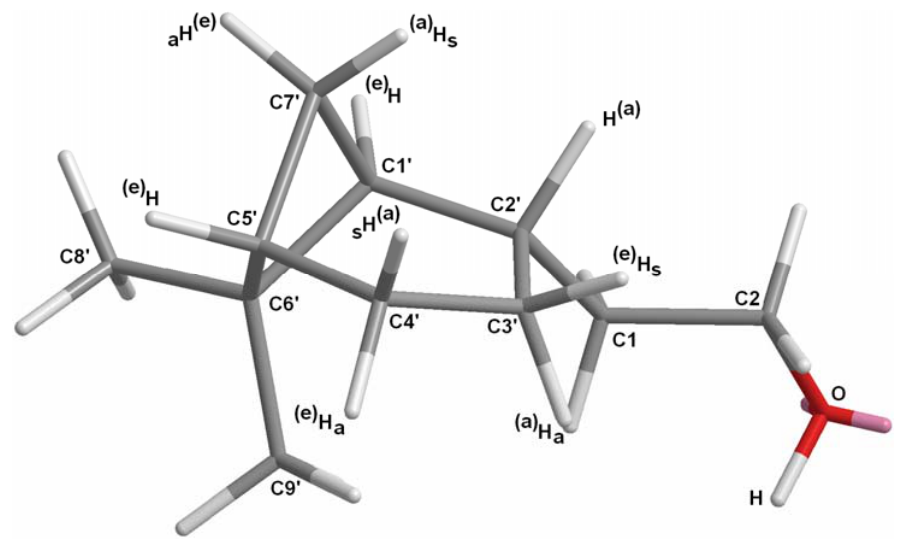
Figure 4. (1 S ,2 S, 5 S )-2-(6,6-dimethylbicyclo[3.1.1]hept-2-yl)ethanol ( 17